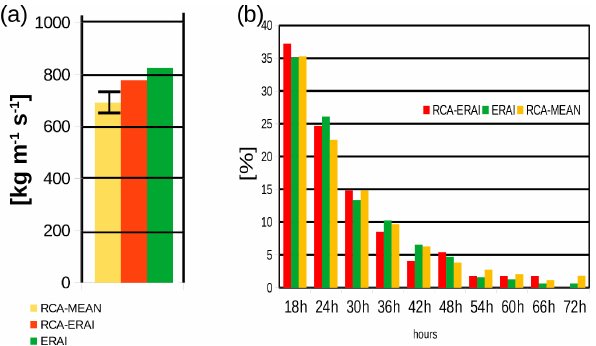
Figure 4. (a) Average AR moisture transport over land for each model realization depicted from the climatological historical pe- riod (RCA-MEAN) as well as for the hindcast simulation (RCA- ERAI) and the reanalysis data set (ERAI). For RCA-MEAN, the range of 2 standard deviations from individual model simulation is given. (b) Histogram of average durations of detected ARs.